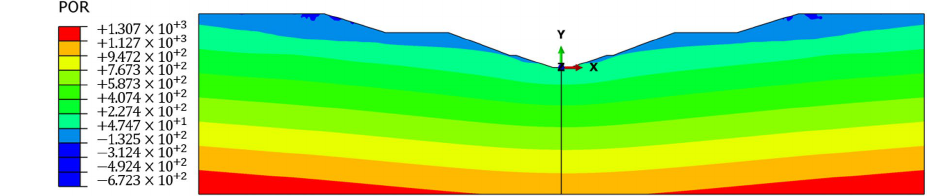
Figure 10. Canal pore pressure contour when t = 10 years.